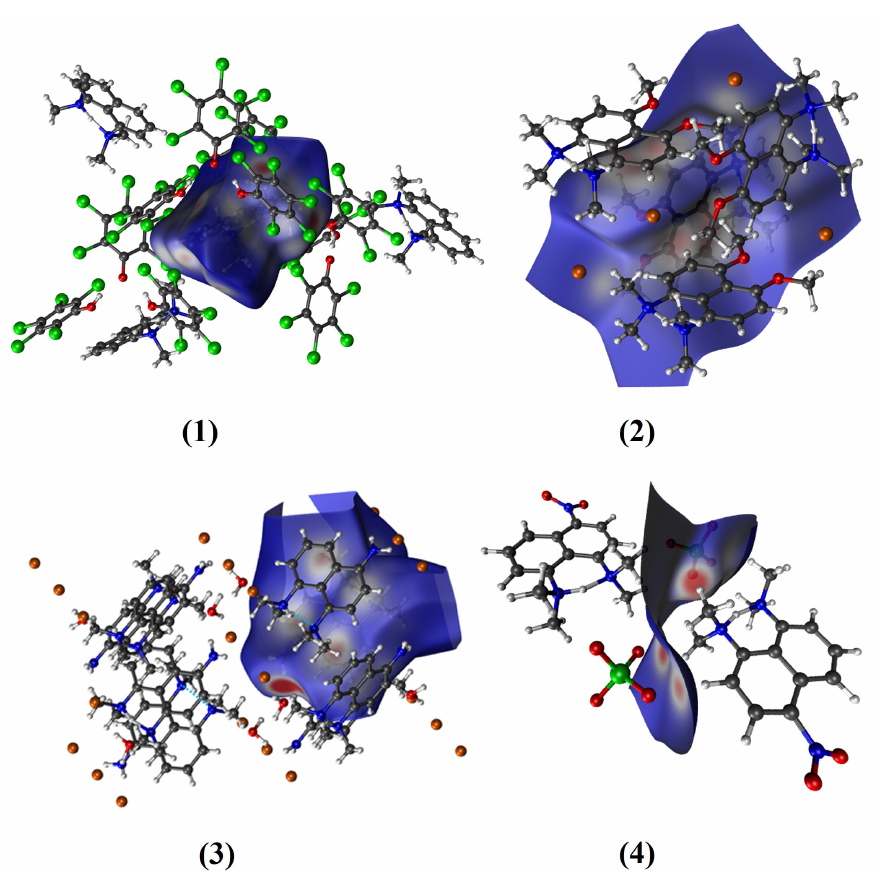
Figure 3. Hirshfeld surfaces obtained for the studied “proton sponge” crystals with empha- sis on intermolecular interactions. Color coding: red—oxygen; blue—nitrogen; gray—carbon; white—hydrogen; green—chlorine; orange—bromine. (1)–(4) indicate the studied